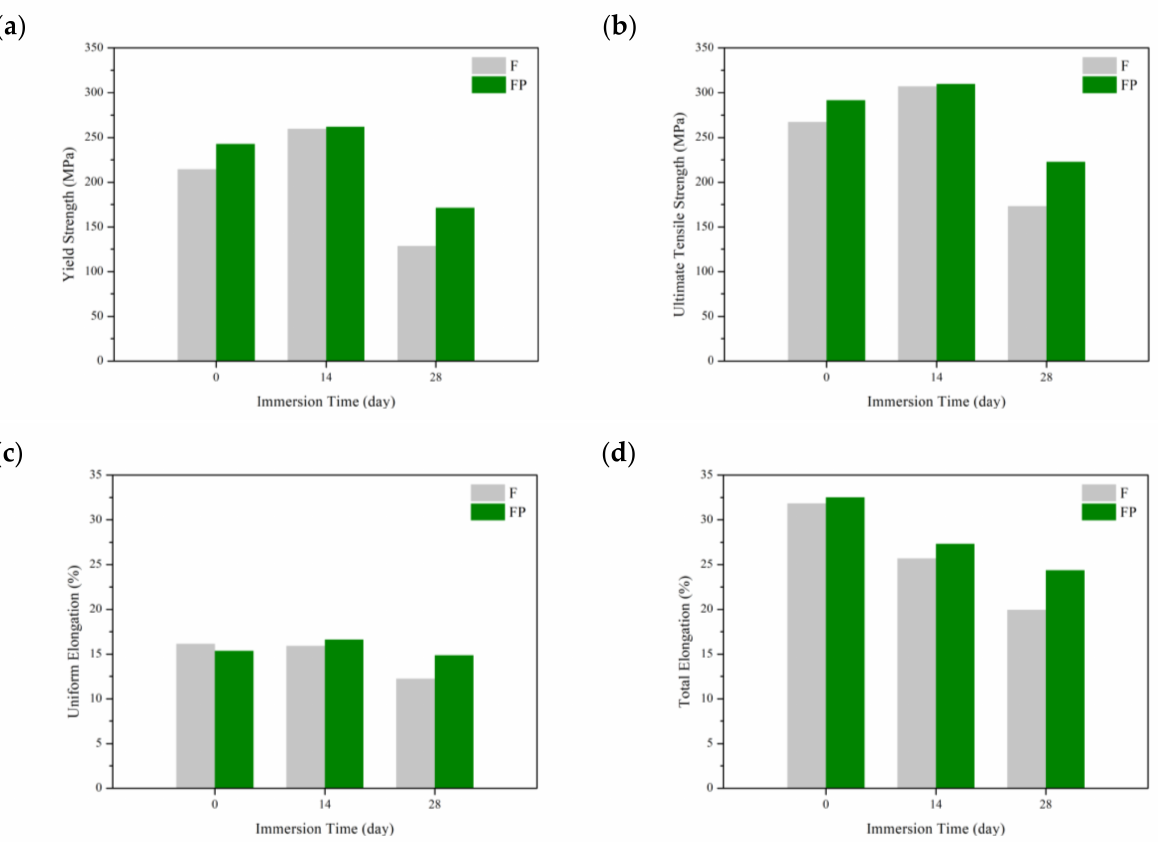
Figure 14. Tensile properties of F and FP before and after immersed in SBF: ( a ) yield strength, ( b ) ultimate tensile strength, ( c ) uniform elongation, and ( d ) tensile